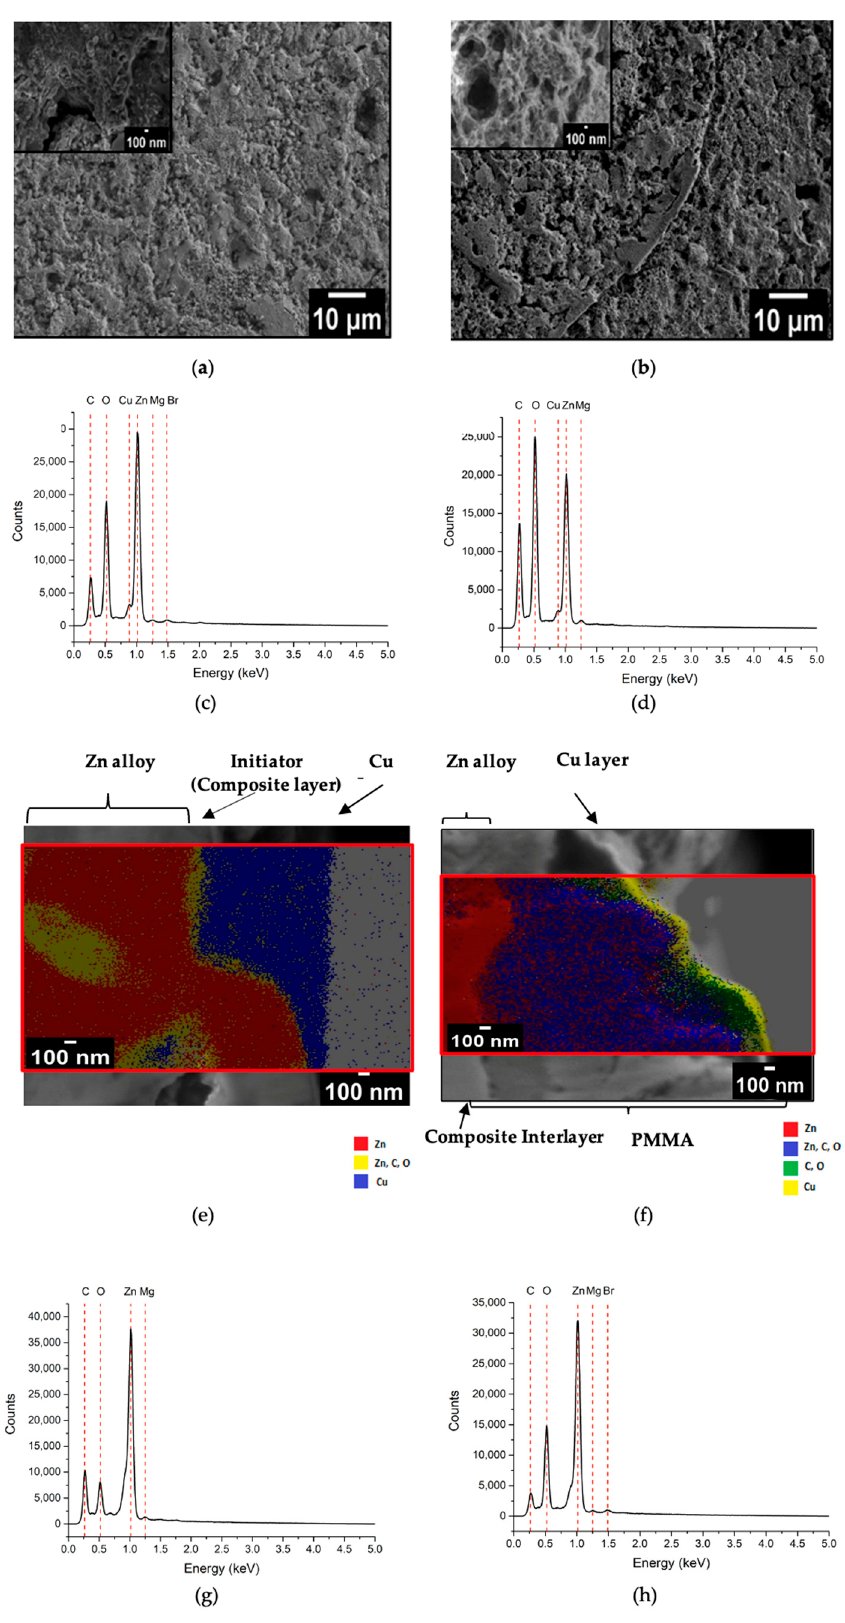
Figure 5. SEM/EDS/elemental mapping of as-coated Zn-1.89Mg: ( a , c ) surface after grafting; ( b , d ) surface after polymerization; ( e , g ) cross-section after grafting; ( f , h ) cross-section after polymeriza- tion.